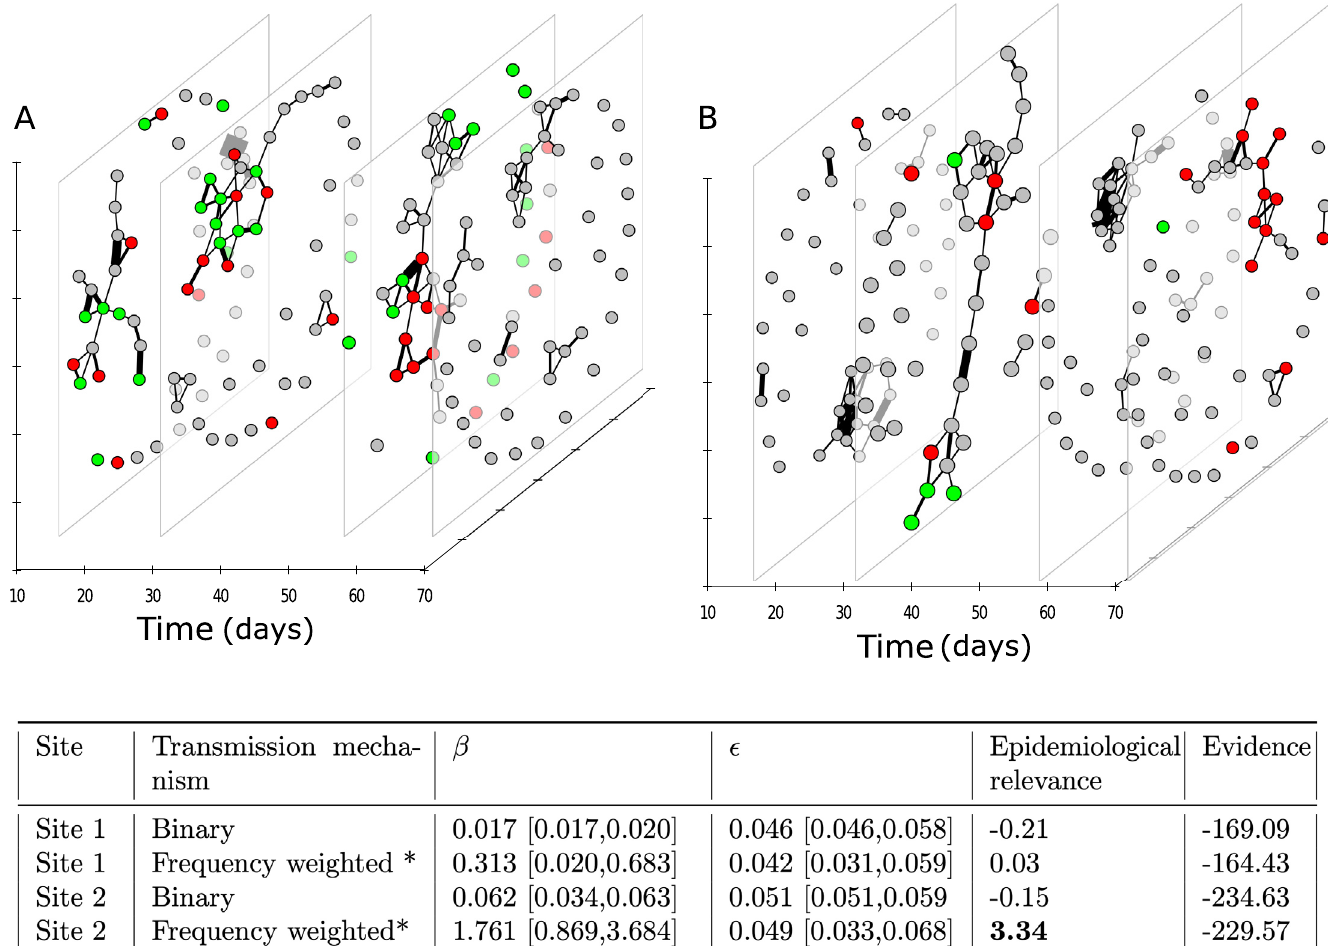
Fig 6. Identifying transmission mechanisms of Salmonella spread in Australian sleepy lizards. Dynamic network of proximity interactions for a total duration of 70 days between (A) 43 lizards at site 1, and (B) 44 lizards at site 2. Each temporal slice summarizes interactions within a day (24 hours). Edges indicate that the pair of individuals were within 14m distance of each other, and the edge weights are proportional to the frequency of physical interactions between the node pair. For ease in visualization, four networks summarizing interactions at day 15, 30, 57 and 70 are shown out of a total of 70 static network snapshots. Green nodes are the animals that were diagnosed to be uninfected at that time-point, red are the animals that were diagnosis to be infected and grey nodes are the individuals with unknown infection status at the time-point. We hypothesized that the spatial proximity networks could explain the observed spread of Salmonella in the population. The results are summarized as a table. Bold numbers indicate that the network hypothesis was found to be epidemiologically relevant compared to an ensemble of randomized networks. The network hypothesis with the highest log Bayesian (marginal) evidence at each site is marked with an asterisk ( �